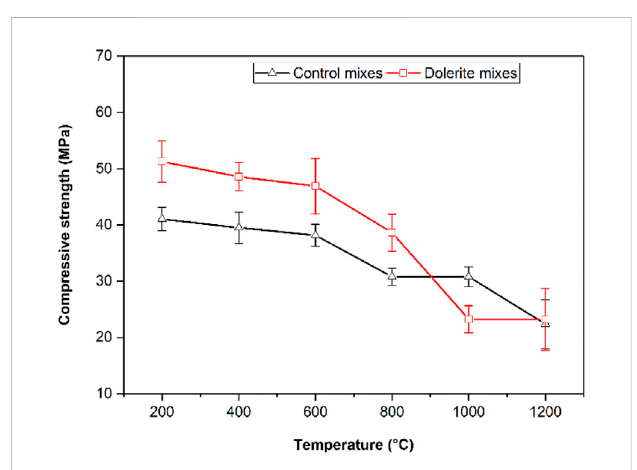
FIGURE 10 Mean and standard deviation of compressive strength against temperature.